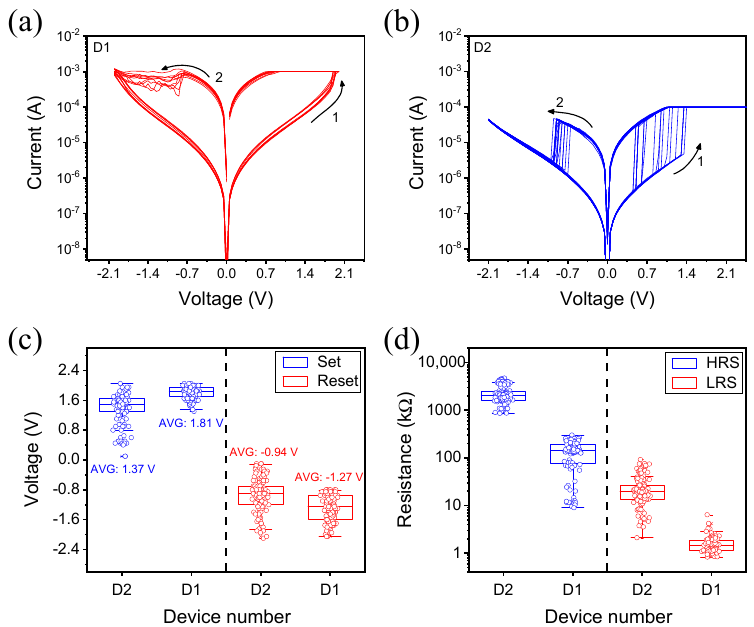
Figure 2. Current–voltage curves of ( a ) the D1 device and ( b ) the D2 device. ( c ) The operating voltage of the set process and reset process are decreased in common. ( d ) A resistance state formed on each device; an increasing aspect is observed after conducting the oxygen plasma treatment.